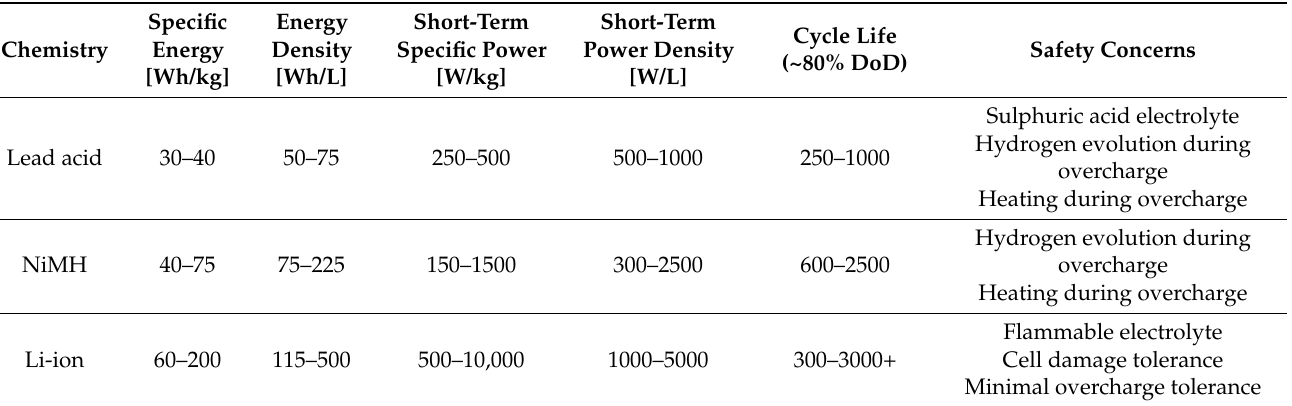
Table 1. Comparison of batteries performance